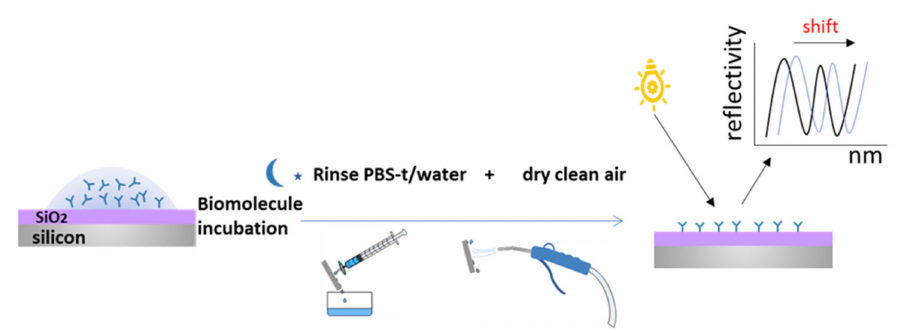
Figure 3. Incubation of molecules on surface, washing, drying, and optical vertical interrogation of the surface for biosensing results.